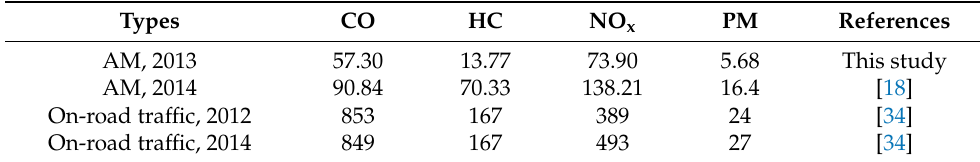
Table 6. Pollutant emissions from AM and on road traffic in Anhui (Gg).